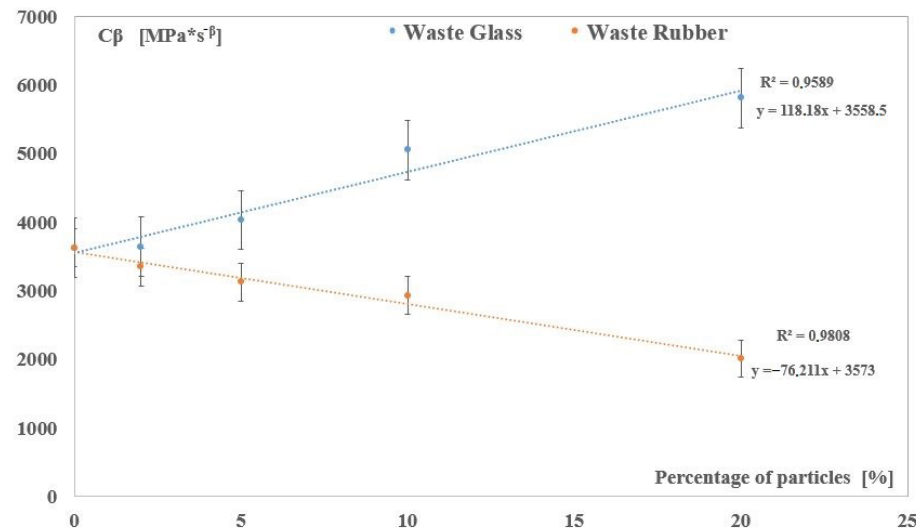
Figure 3. C β comparison between glass and rubber waste particles filled composites.